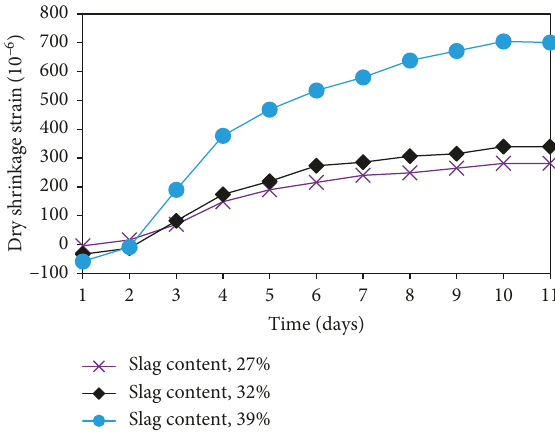
Figure 15: Dry shrinkage strain for CTB.